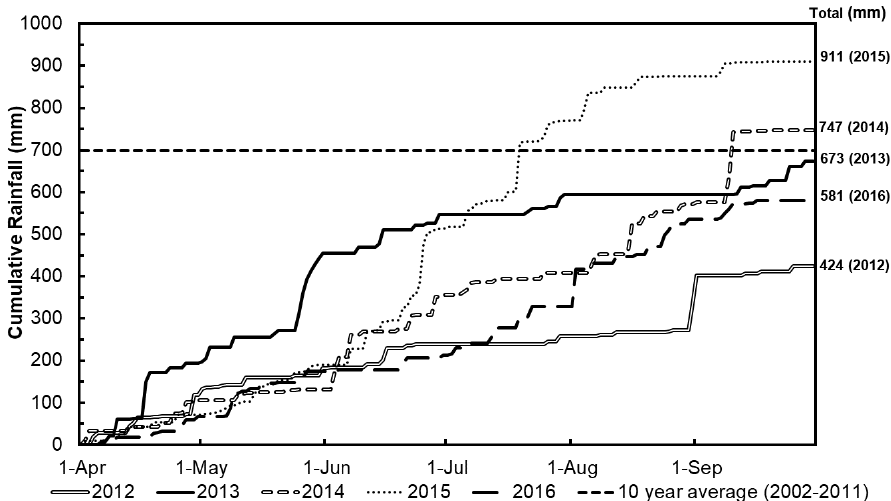
Figure 2. Cumulative precipitation during the 2012 to 2016 growing seasons and the 10 (2002 to 2011)-year average (699 mm) at the Greenley Memorial Research Center near Novelty, Missouri (USA) .